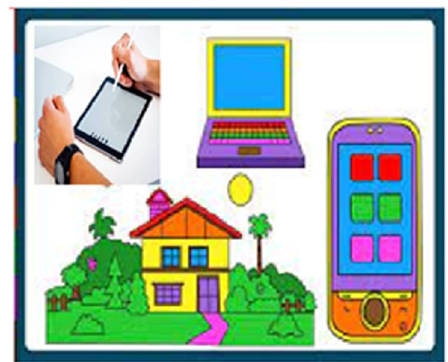
Fig. 4 G2 ’ s adapted visual representation. This fi gure shows how EFL learners perceive the role of technology in language